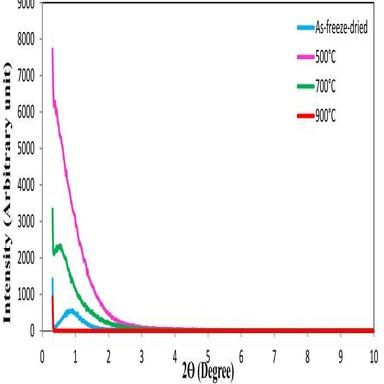
Small angle X-ray patterns of as-freeze-dried sample and samples calcined at 500 ◦C, 700 ◦C and 900 ◦C.